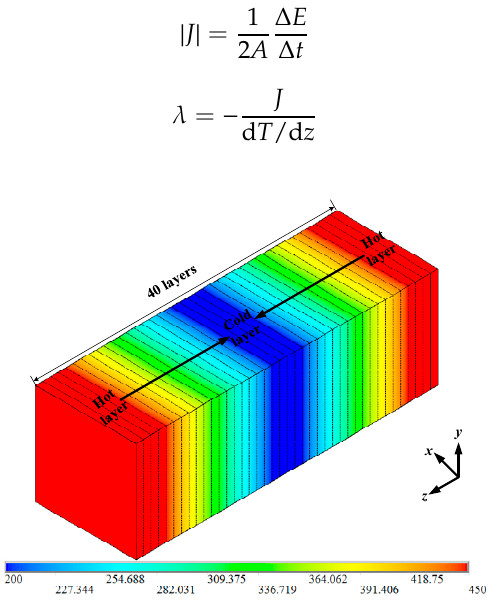
Figure 8. Temperature distribution between cold and hot layers.